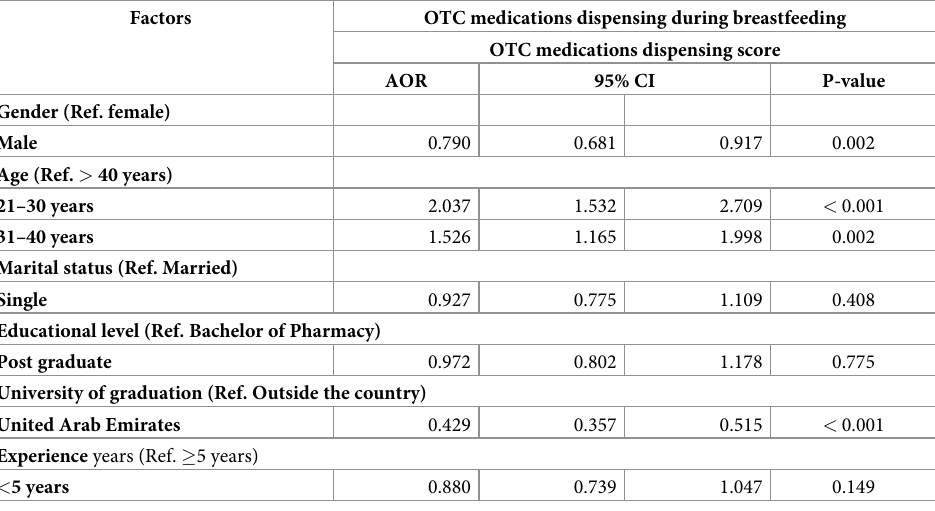
P-values less than 0.05 were considered statistically significant, Abbreviations : AOR, adjusted odds ratio; CI, confidence